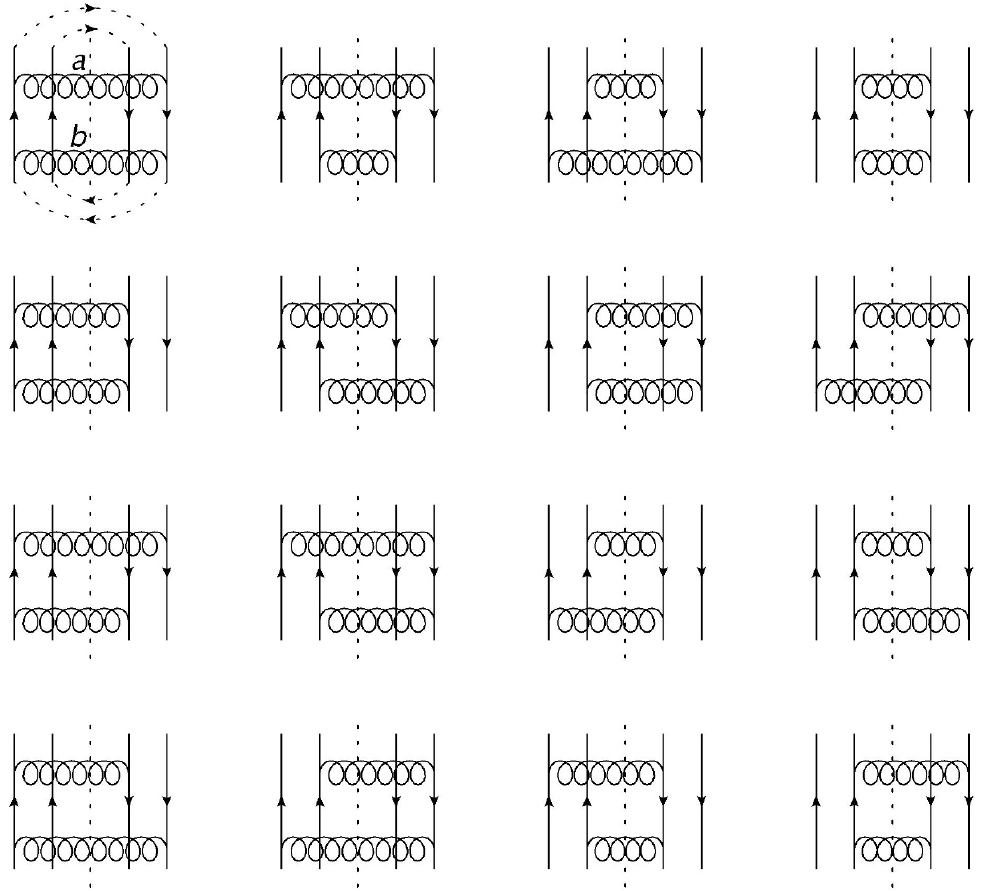
Figure 2 . The 16 diagrammatic contributions to the 2-gluon emission spectrum from 2 sources. In each of the 16 diagrams, contributions from the amplitude (complex conjugate amplitude) are on the left (right) hand side of the dotted line. Averaging (summing) over the initial ((cid:12)nal) state closes the color (cid:13)ow as illustrated by the dashed arrows in the top left hand diagram. This color (cid:13)ow implies that the eight diagrams in the third and fourth row